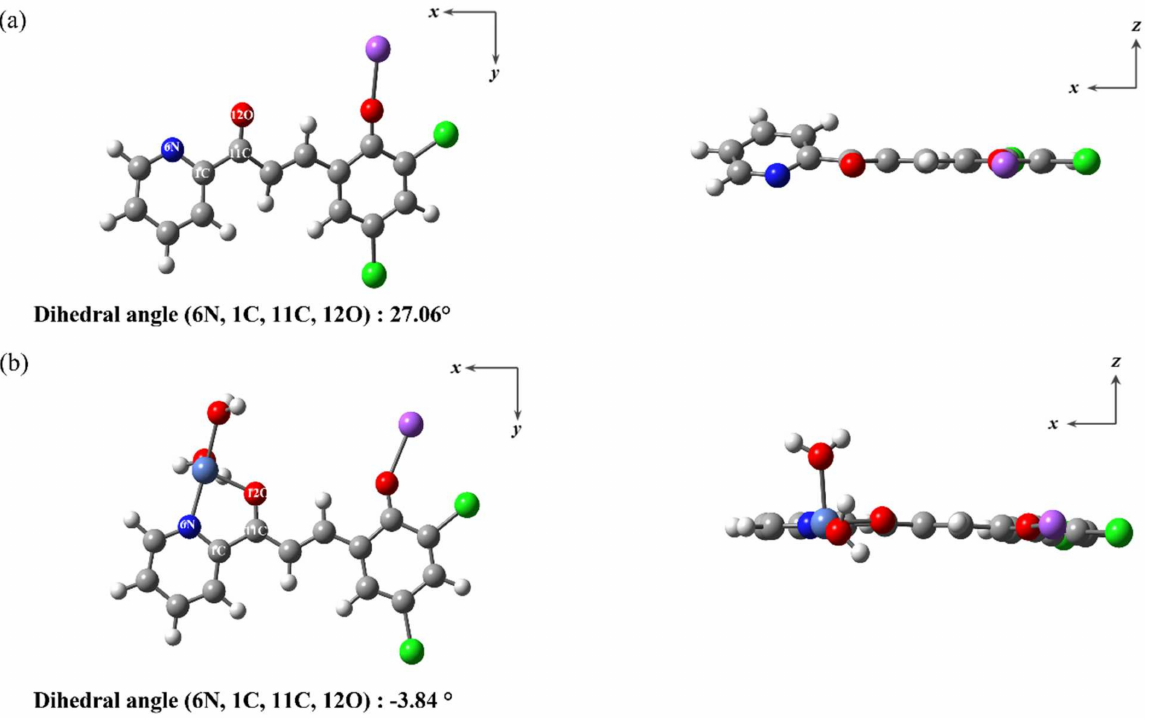
Figure 10. Energy-optimized forms of ( a ) DPP and ( b ) DPP -Ni 2+